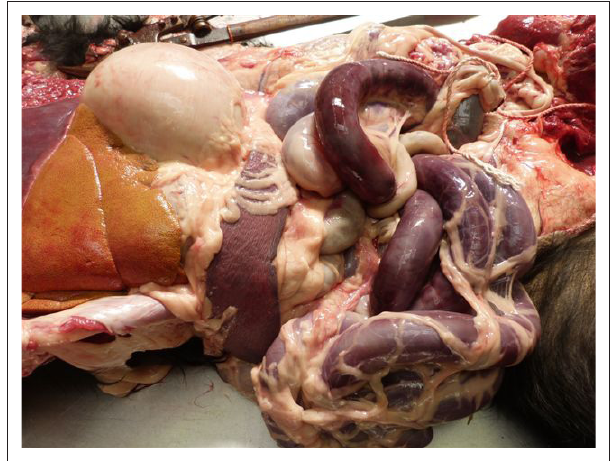
FIGURE 1: In dogs ( n = 31) submitted for necropsy with suspected aflatoxicosis, all 31 exhibited fatty hepatosis and enterorrhagia.